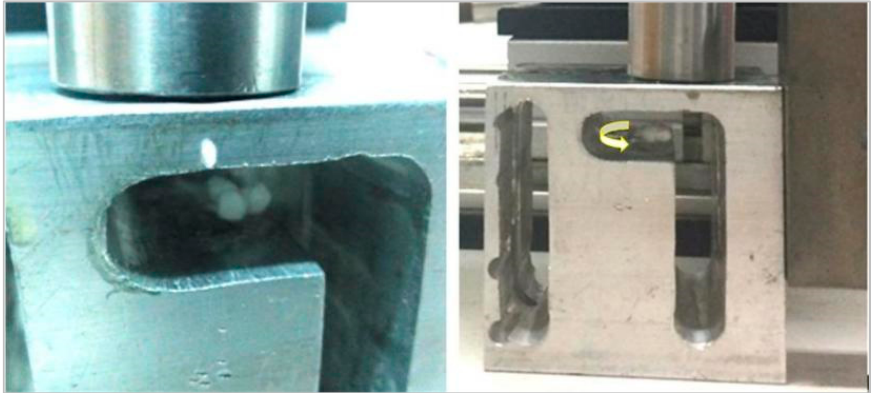
Figure 11. Particle rotation inside metal structure.